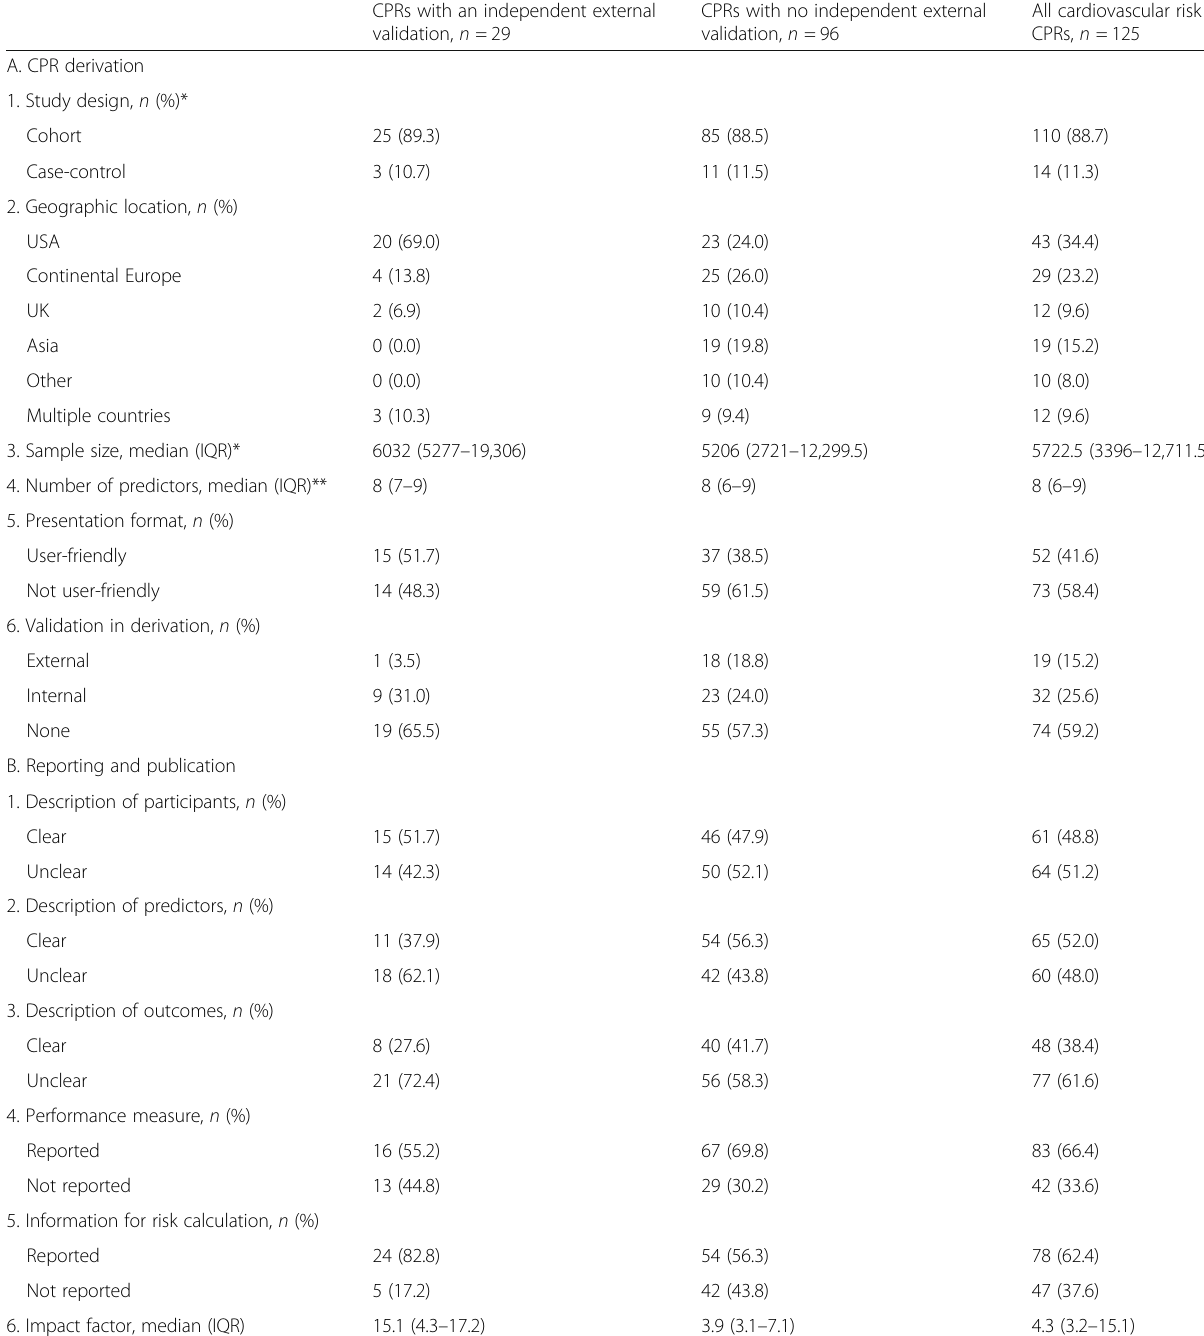
Table 1 Characteristics of cardiovascular risk clinical prediction rules (CPRs)